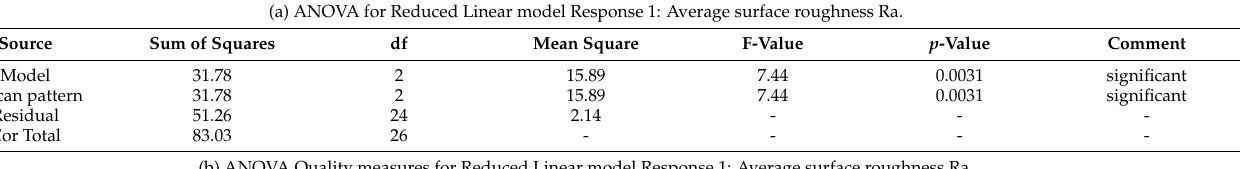
Table A2. ANOVA results: Average surface roughness Ra. (a) ANOVA for Reduced Linear model Response 1: Average surface roughness